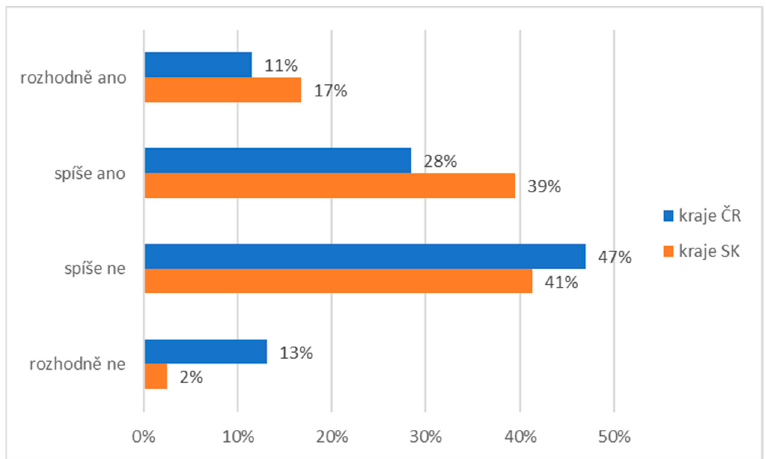
Figure 9. Descriptive statistics of the participants’ attendance in social and pastoral service (com- parison of the healthy population of eastern Slovakia and north-western Czech Republic). Legend: CZ—healthy population of north-western Czech Republic, SK—healthy population of eastern Slo- vakia. Source: own resource.